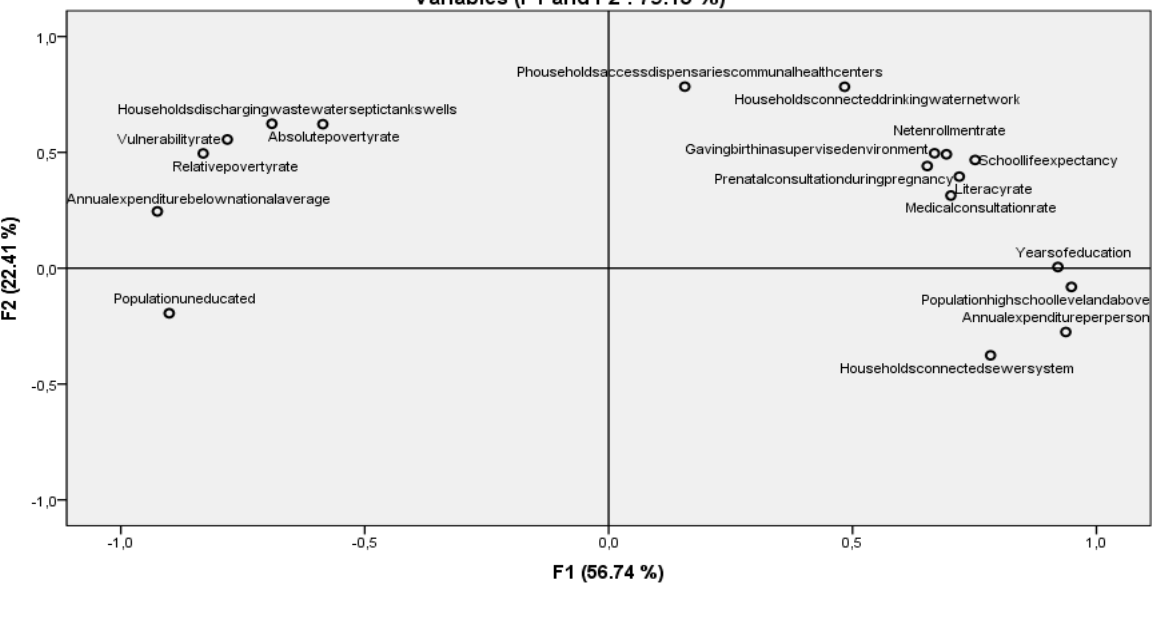
Figure 1: Projection of the indicators on the factorial plane (F1,